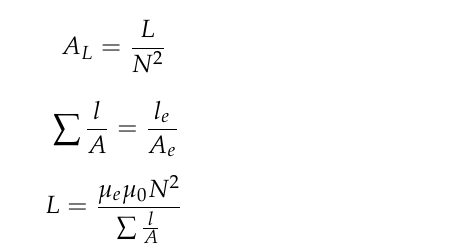
Figure 7. Planar transformer developed in this paper. 2.4. Band ‐ Pass Filter Module, Demodulation Module, and Analog ‐ to ‐ Digital Conversion Module The band ‐ pass filter module selects the frequency of the signal output by the AC ‐ amplifier module and filters out the frequencies other than the excitation signal. The band ‐ pass filter in this paper uses a low ‐ pass filter in series with a high ‐ pass filter, and finally adjusts the amplitude to ensure that the output amplitude remains unchanged. As shown in Figure 8, the bandwidth range is 71 kHz~139 kHz. Since the demodulation module is not ideal, large out ‐ of ‐ band noise may leak into the demodulated frequency band. There ‐ fore, for a narrower bandpass filter, the design difficulty of the demodulation module will be reduced. On the other hand, the gain of a filter with a very narrow passband is more sensitive to changes in its components (resistors and capacitors) with temperature, for